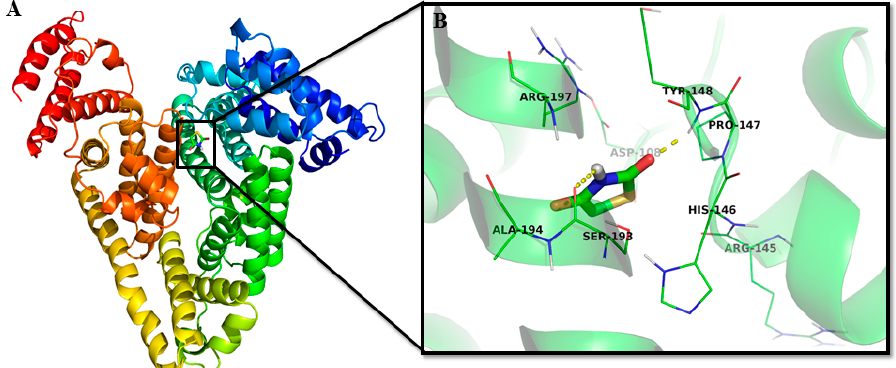
Figure 3. Molecular interactions between 2,4-TZD and HSA. ( A ) The binding site of 2,4-TZD at subdomain IB of HSA, and ( B ) Amino acid residues and the nature of the interaction between 2,4-TZD and HSA. Table 4. Molecular docking between HSA and 2,4-TZD using AutoDock4.2. Nature of Interaction Category of